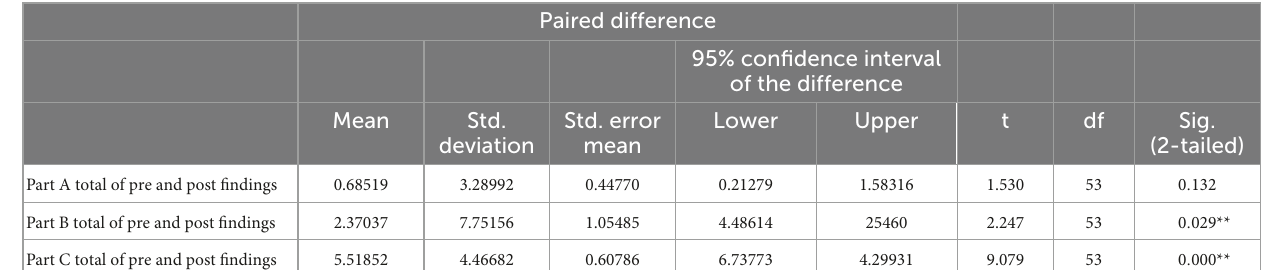
TABLE 5 Overall outcome of the paired t -test for the pre and post surveys.